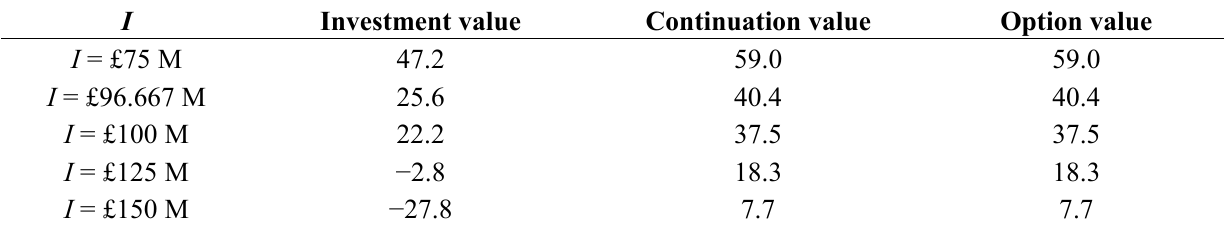
Table 14. Option value (£M) under the electricity market